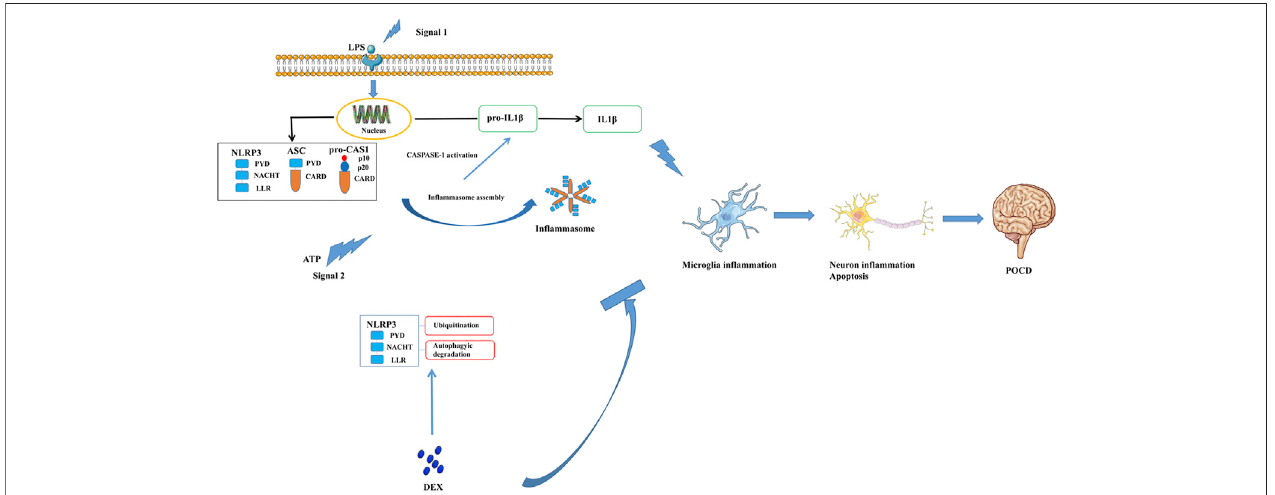
FIGURE 7 | Dexmedetomidine, an α 2 adrenergic receptor agonist, alleviates the cognitive function via blocking the activation and assembly of NLRP3 in fl ammasome and accelerated the degradation of NLRP3 through the ubiquitin-autophagy pathway. Consequently, neuroin fl ammation level induced by surgery was reduced, thenPND of mice has been